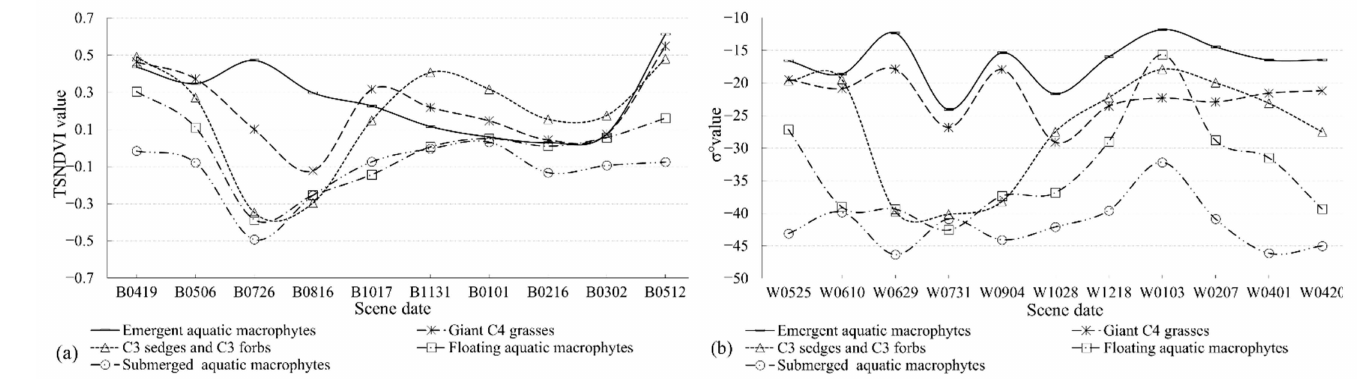
Figure 5. Time-series curves extracted from Beijing-1 and ASAR data: ( a ) phenological curve extracted from Beijing-1 time-series NDVI images; ( b ) permittivity curve extracted from ASAR time-series backscattering coefficients images. (Scene date is given as image source, month, day. B represents Beijing-1 and W represents ASAR WSM. For example, B0419 is Beijing-1 image acquired on 19